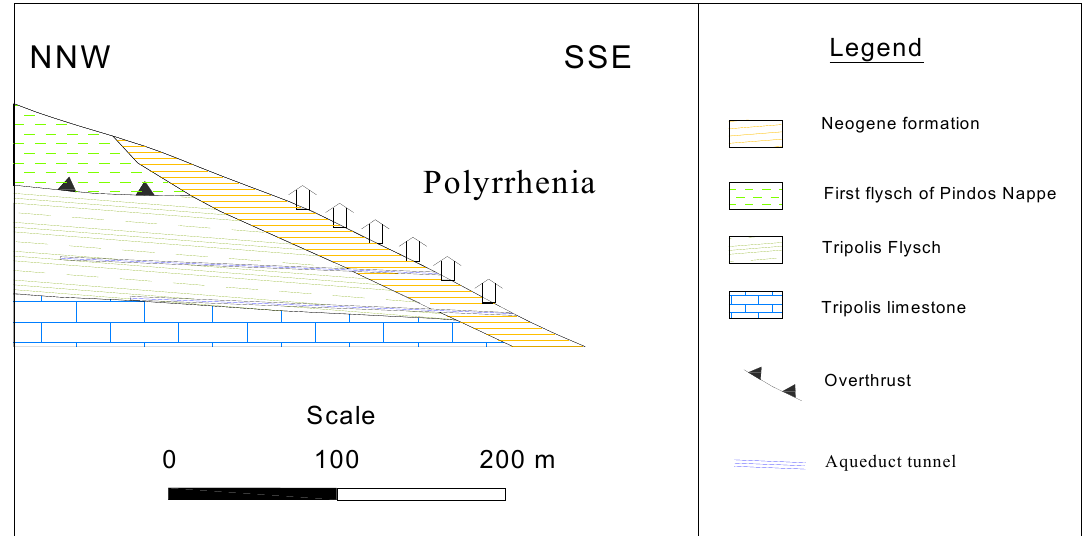
Figure 11. Simplified cross section illustrating different geological formations and the aqueduct tunnels in